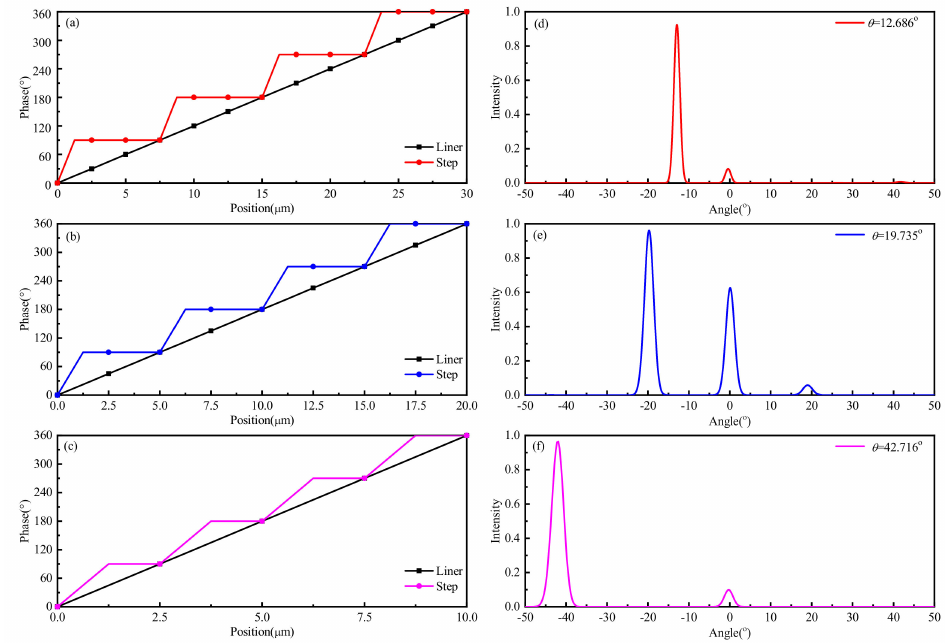
Figure 8. Phase-gradient profile for target beam-steering angles of ( a ) 13.10 ◦ , ( b ) 19.87 ◦ and ( c ) 42.84 ◦ , theoretically. Full-wave simulation results of the beam steering metasurface for ( d ) 12.686 ◦ , ( e ) 19.735 ◦ and ( f ) 42.716 ◦